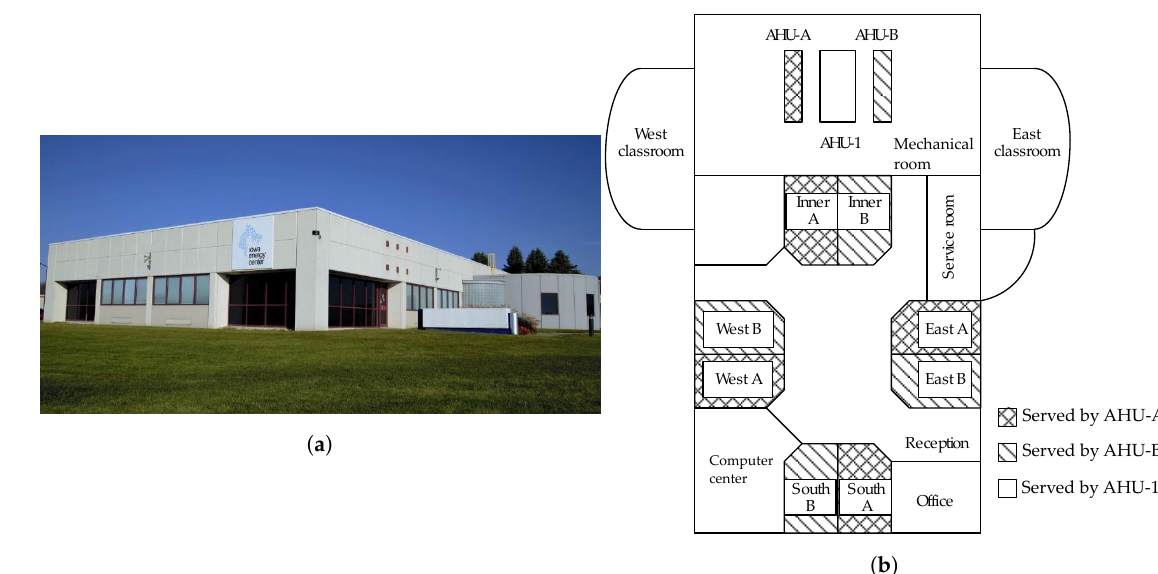
Figure 3. Energy Resource Station (ERS) facility used o obtain the data on the ASHRAE RP-1312: ( a ) Exterior view of the facility. ( b ) ERS floor plan with the zones served by the different AHUs.